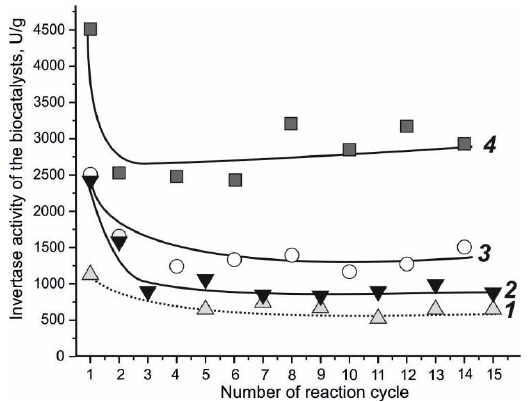
Figure 6. The invertase activity of lysate-based biocatalyst in dependence of type of nanocarbon included and numbers of reaction cycles of sucrose inversion: 1 —without nanocarbon (dotted line), 2 —CNFs, 3 —CNS1s, 4 —CNT1s. Reaction conditions: 50 °C, 2 M sucrose, 0.02 M acetate buffer pH 4.6.